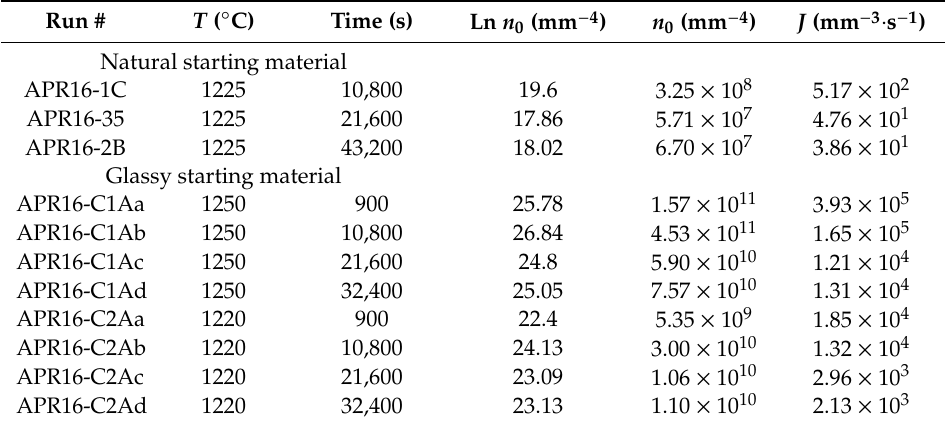
Table 4. Calculated nucleation rate values for clinopyroxene.